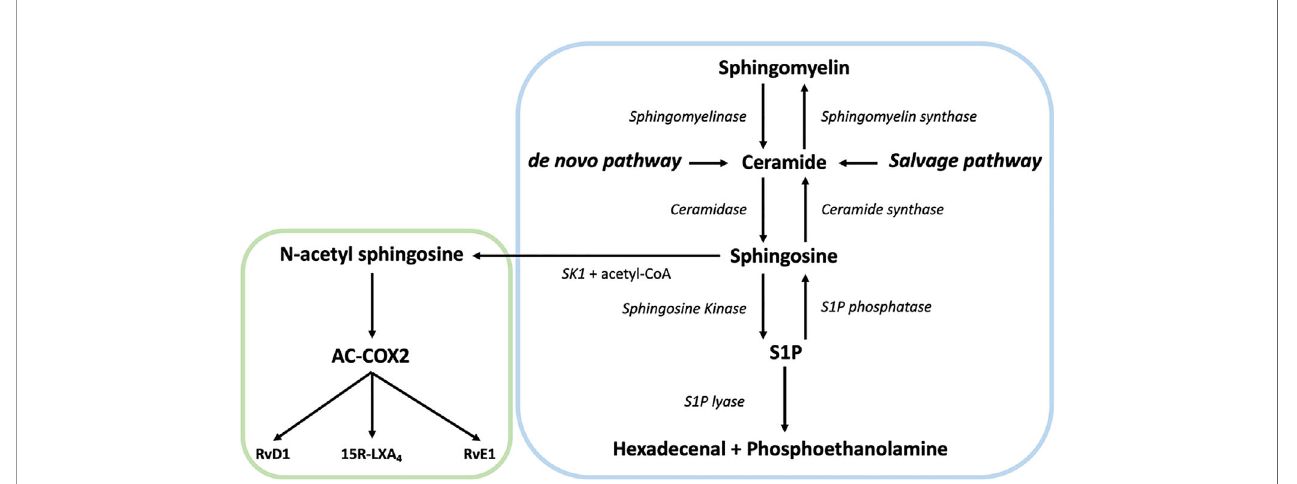
FIGURE 1 | Overview of the sphingolipid (SL) rheostat model and the interplay with specialized pro-resolving mediator (SPM) metabolism. Ceramide can be synthesized by ceramide synthases via the de novo and the salvage pathway from sphingosine or by hydrolysis of sphingomyelin by sphingomyelinase. Once generated, ceramide can act as substrate for other sphingolipids such as sphingosine and sphingosine-1-phosphate (S1P) via sphingosine kinase (SK). S1P can be catabolized into hexadecenal + phospho-ethanolamine by the action of sphingosine 1-phosphate lyase. Alternatively, SK can generate N-acetyl sphingosine via acetyl-CoA and sphingosine, followed by the acetylation of COX-2. In turn, this activates COX-2 mediated 15-HETE, 18-HEPE and 17-HDHA production, which can be converted to SPMs like such as 15R-LXA 4 , RvE1, and RvD1, thereby providing a direct link between the SL and SPM